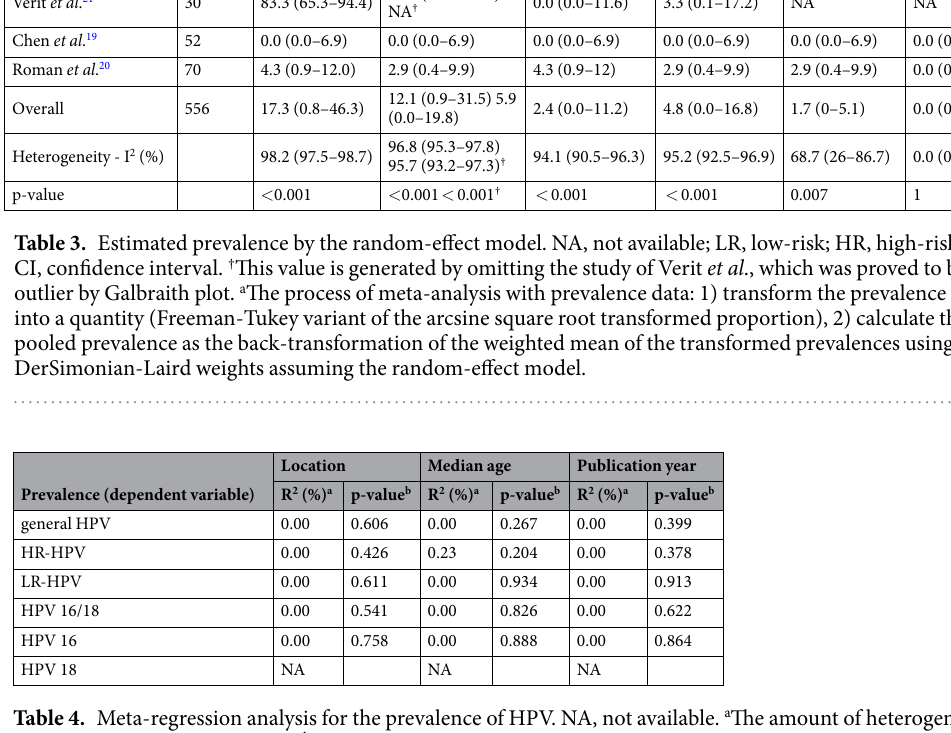
Table 4. Meta-regression analysis for the prevalence of HPV. NA, not available. a The amount of heterogeneity accounted for by the moderator. b p-value for the Wald-type test of the